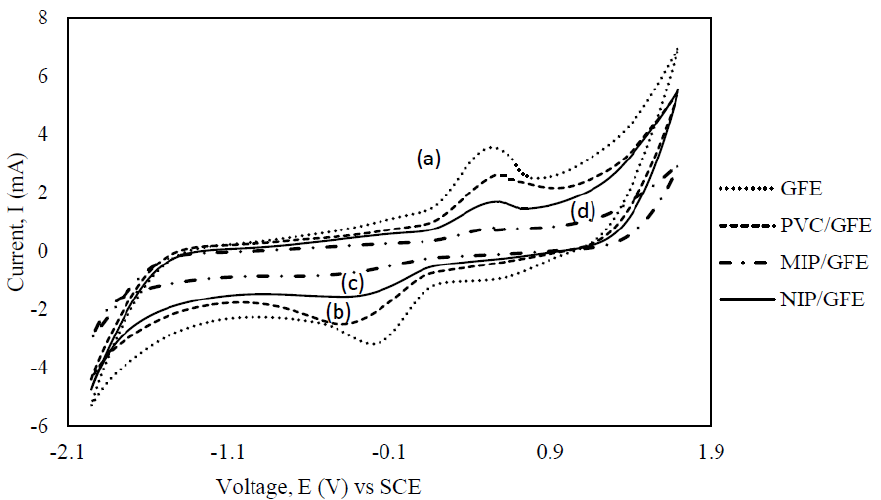
Figure 9. Cyclic voltammograms obtained using the ( a ) GFE ( b ) PVC/GFE ( c ) NIP/GFE, and ( d ) a MIP/GFE in 20 ppm of atrazine.